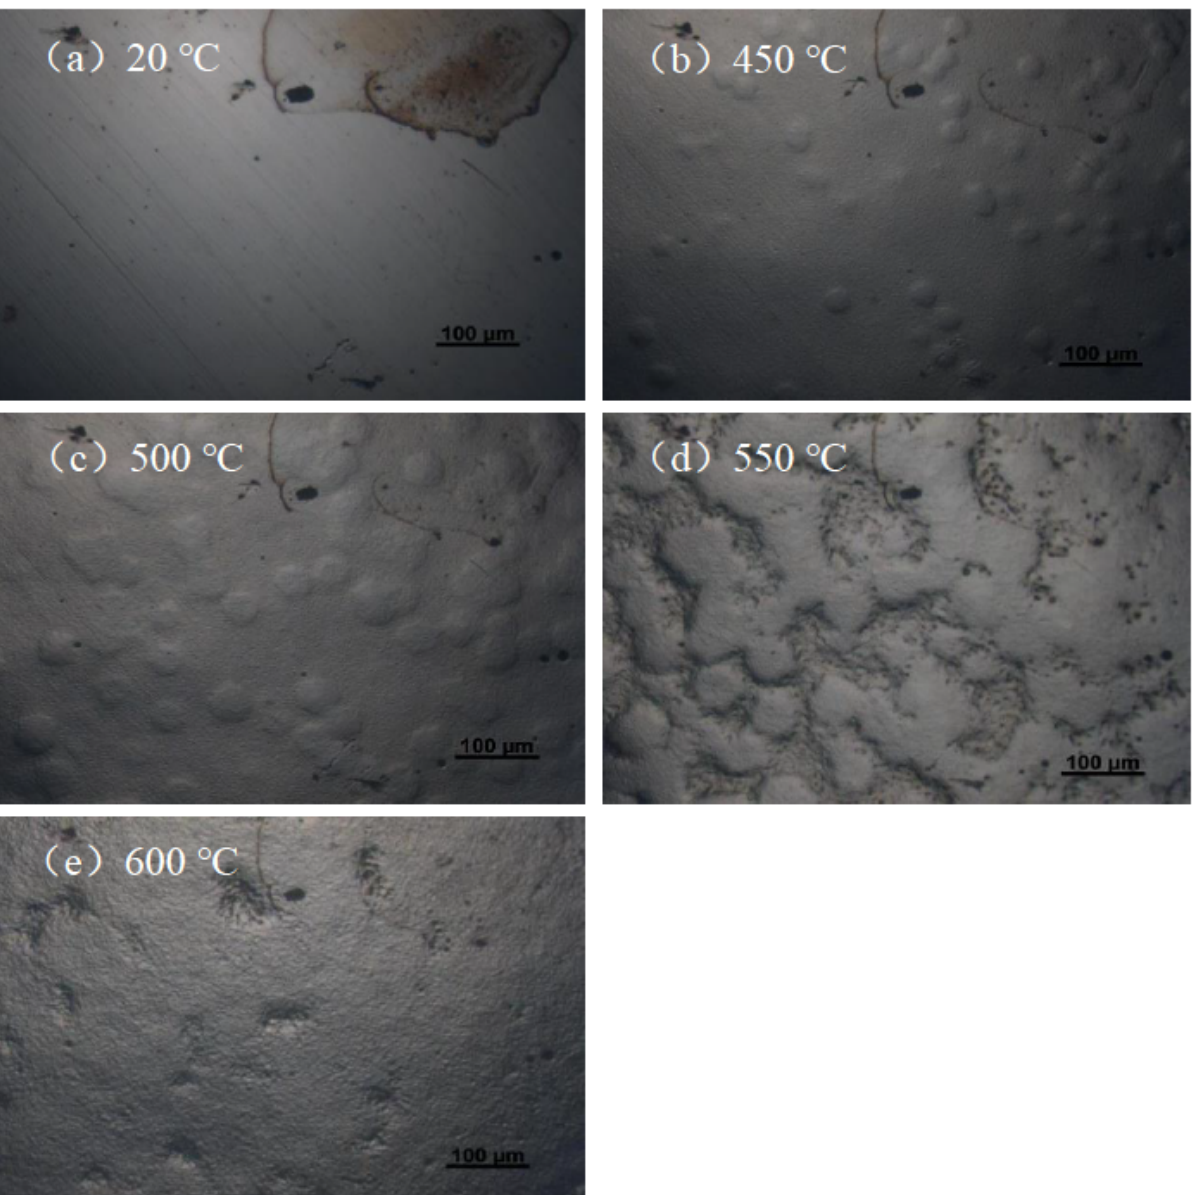
Figure 2: Surface morphology evolution during heating of the amorphous brazing filler metal during heating process at (a) 20, (b) 450, (c) 500, (d) 550 and (e) 600 ∘